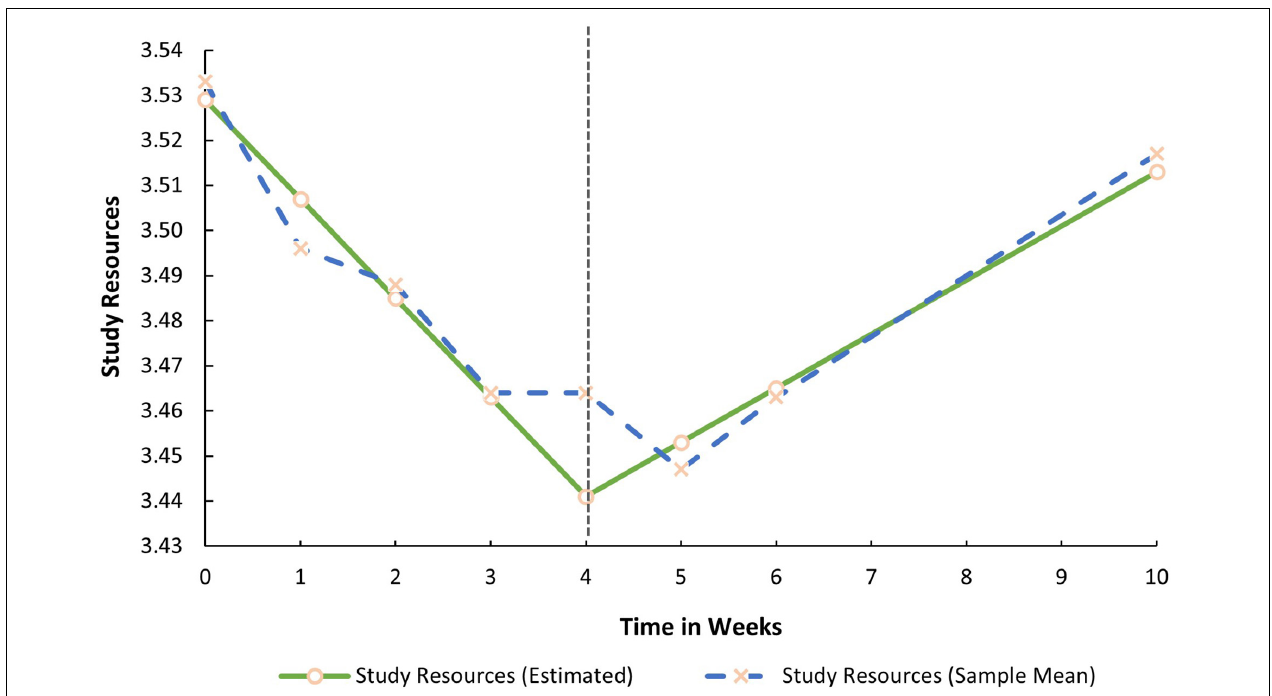
FIGURE 1 | Estimated trajectory of study resources before and during the COVID-19